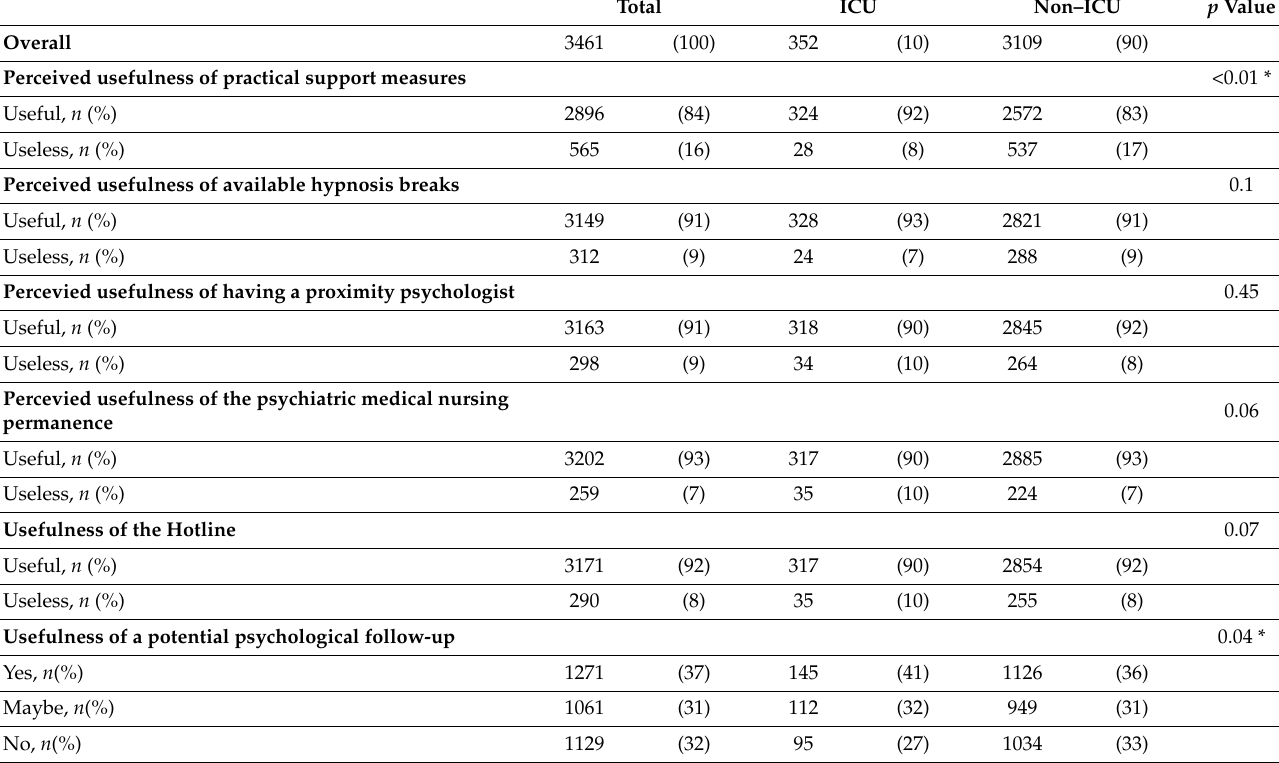
Table 4. Perceived usefulness of practical and mental health support measures by